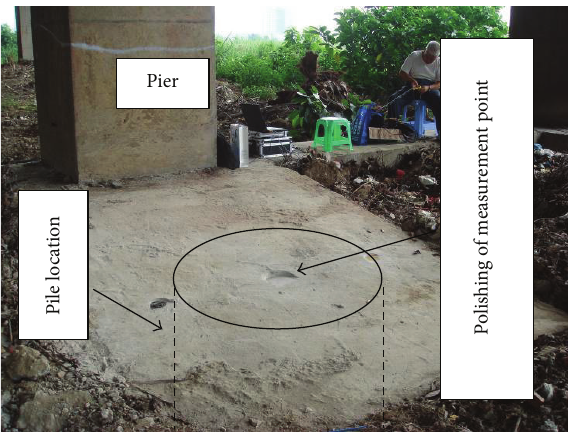
Figure 5: Surface polishing where the sensors are located.